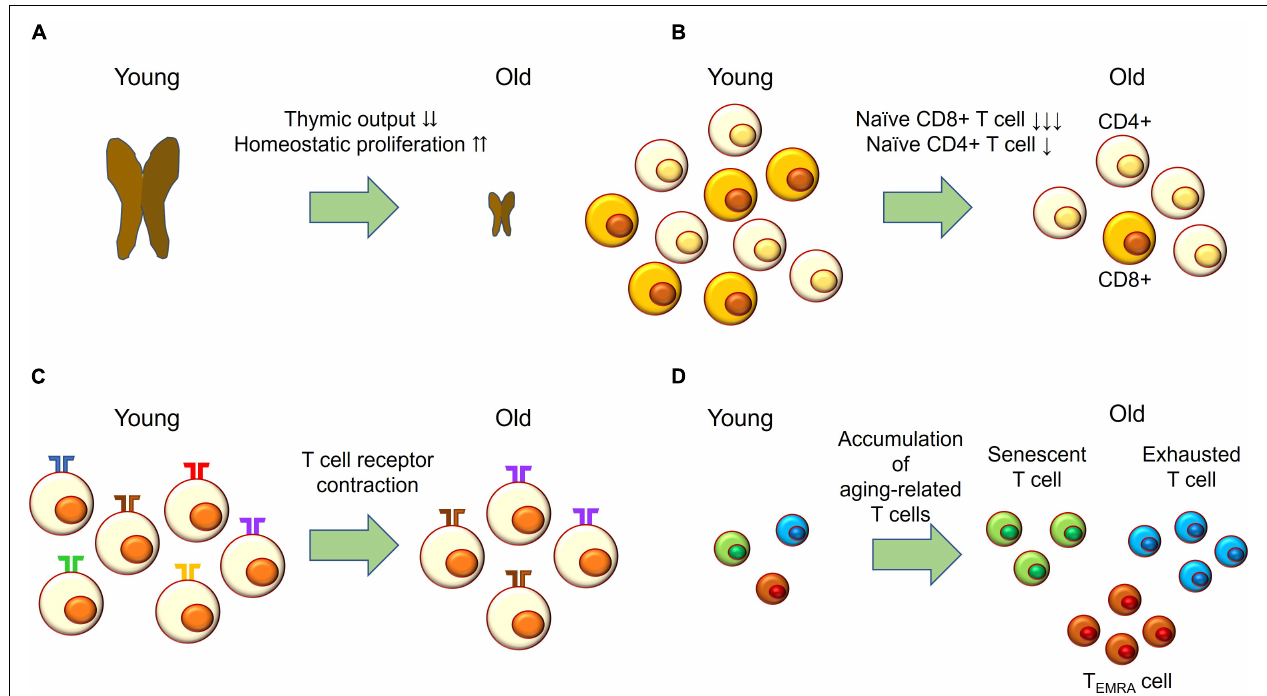
FIGURE 2 | T cell aging. (A) With age, thymic output drastically decreases and the naïve T cell compartment is maintained by homeostatic proliferation. (B) Naïve CD4 + T cells slightly decrease in absolute number with age; while naïve CD8 + T cells drastically decrease with age. (C) The number of T cell receptors—also called the T cell repertoire—declines with age, while clonal sizes increase with age. This process is called T cell receptor contraction. (D) T effector memory CD45 RA (TEMRA) cells; exhausted T cells expressing PD-1, TIM-3, and LAG-3; and senescent T cells accumulating with